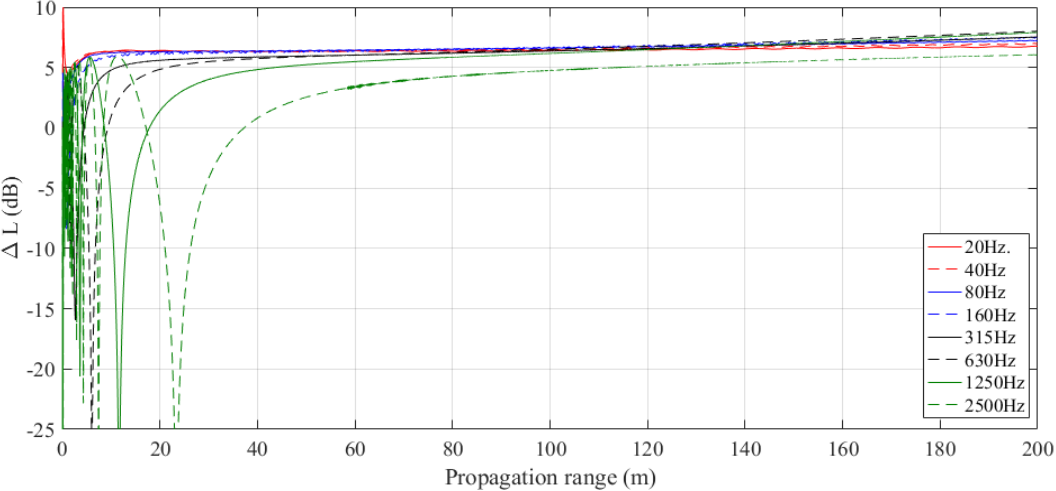
Figure 5. Sound transmission loss over 200 m at various frequencies (rigid ground and downward refraction).